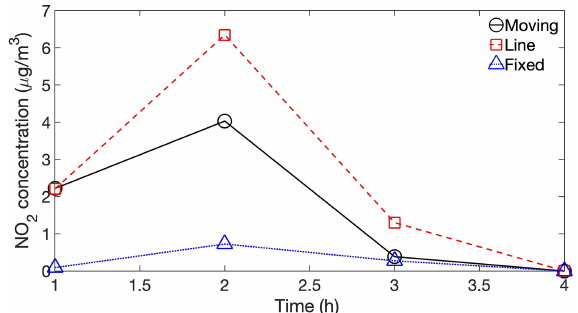
Figure 16. Hourly averaged NO 2 concentrations at a fixed point (“data point” in Fig. 3b) simulated by using different emission source